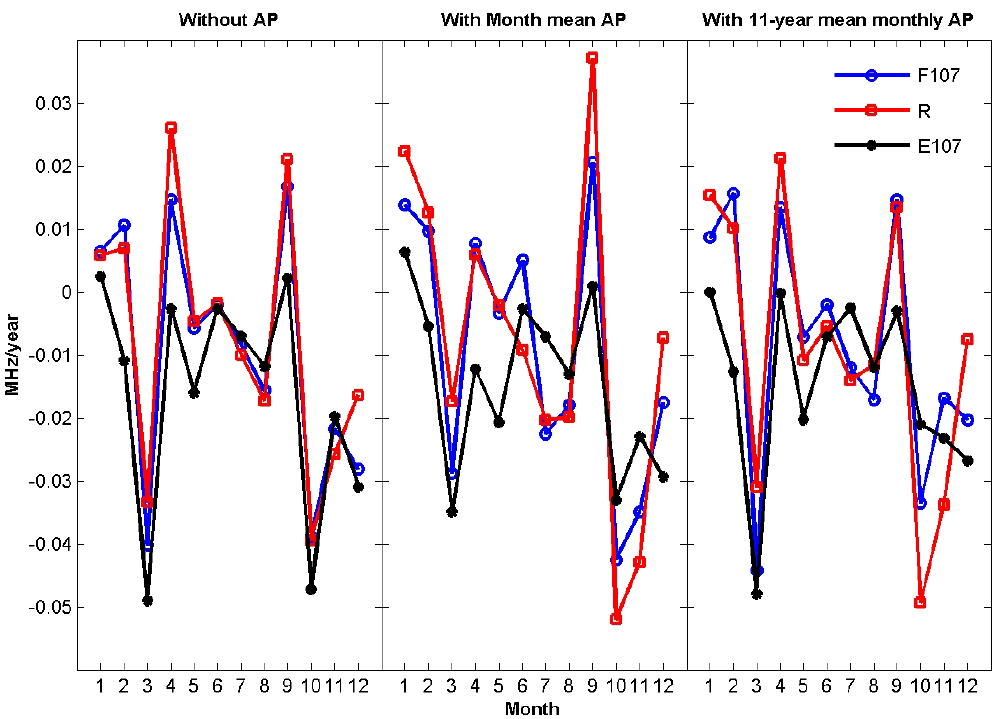
Fig. 2. Seasonal variation of trends based on monthly mean values of fo F2 and solar proxies (F10.7 – circles; E10.7 – squares; R – asterisks) for no correction to A p (left panel), correction with monthly mean A p (middle panel), and correction with 11-year mean monthly A p (right